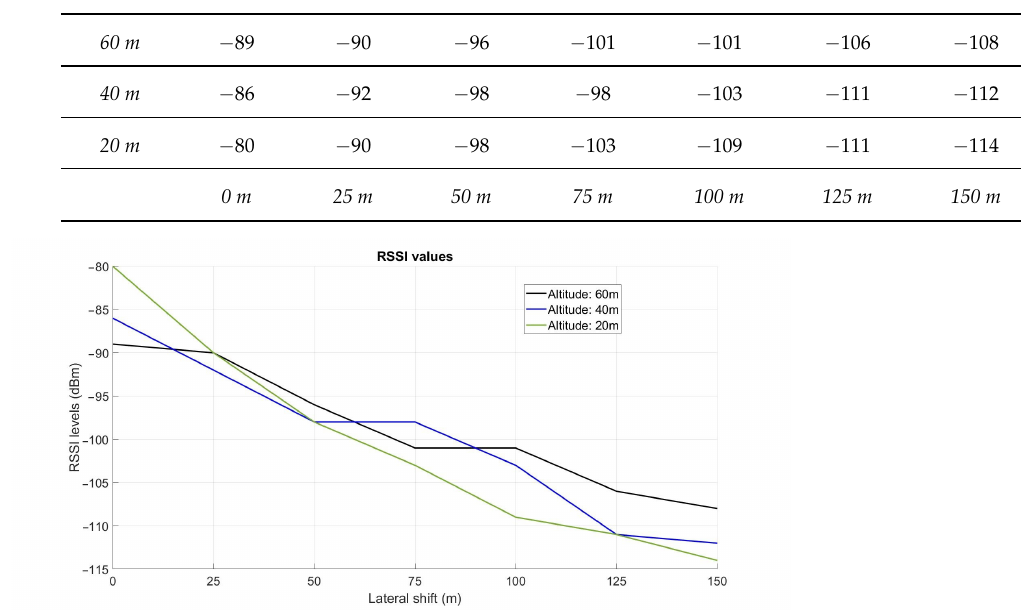
Figure 15. RSSI levels for each position of the UAV. Table 3. Mean of the RSSI values (dBm) at each position (altitude, lateral distance).